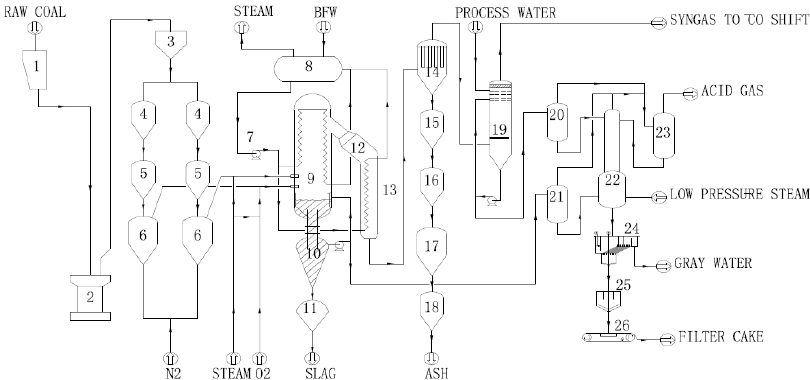
Figure 2. Schematic diagram of the entrained-flow gasification of the Huaneng Clean Energy Research